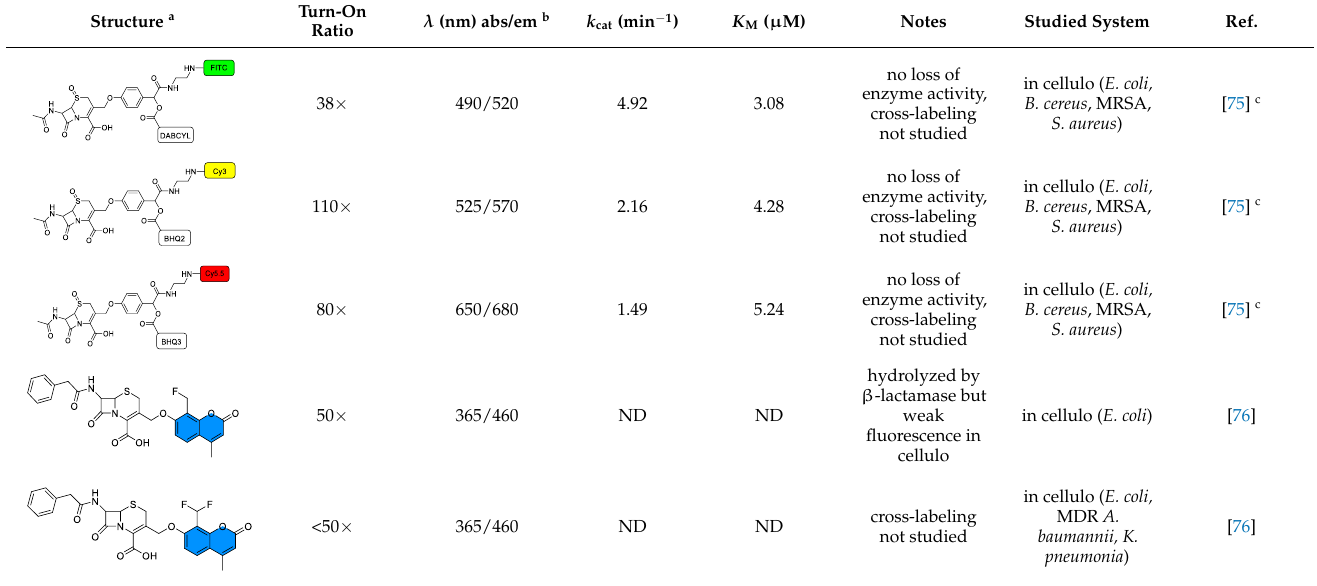
Table 9. Activity-based probes for β -lactamases. Structure a